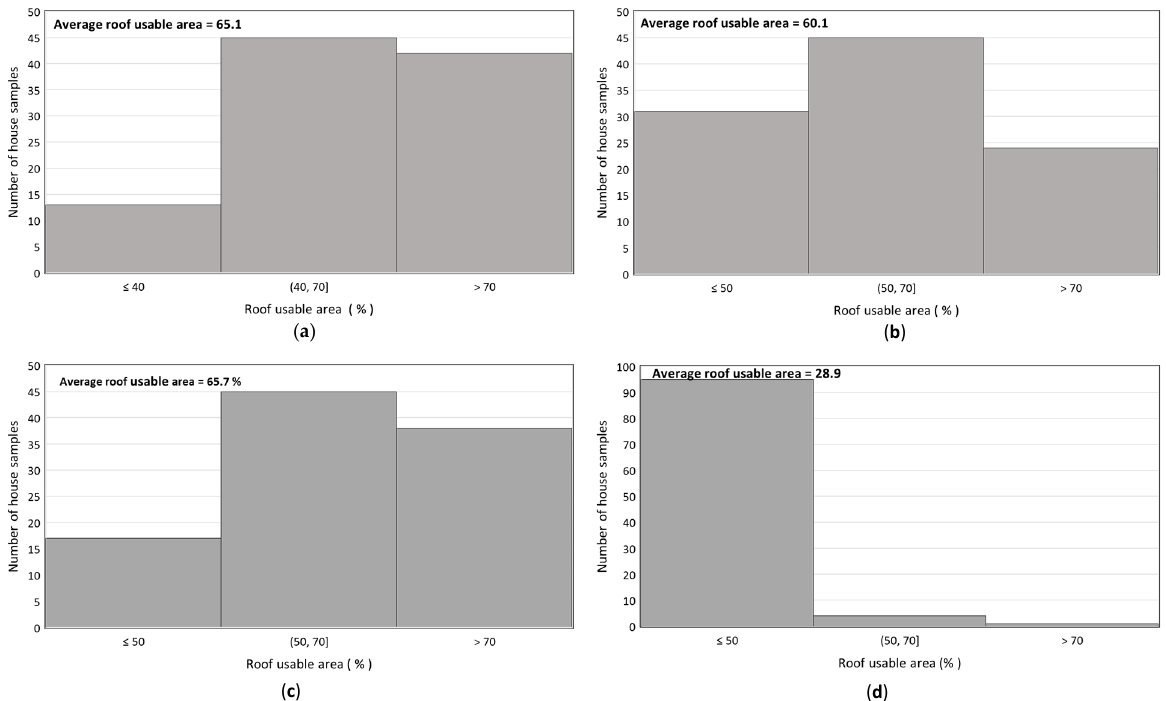
Figure 5. The distribution of roof useable area in four suburbs: ( a ) Newtown, ( b ) Redfern, ( c ) Erskineville, ( d ) Rosebery.